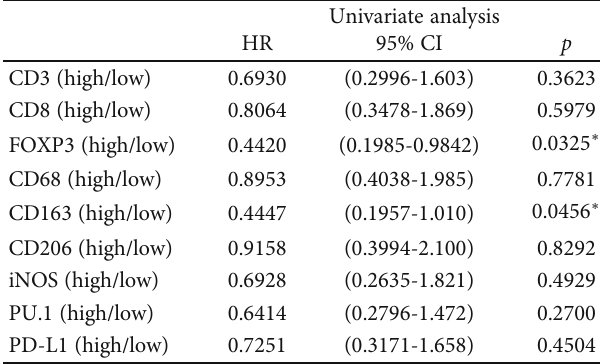
Table 4: Statistical analysis of the prognostic value of immune cells of tumor